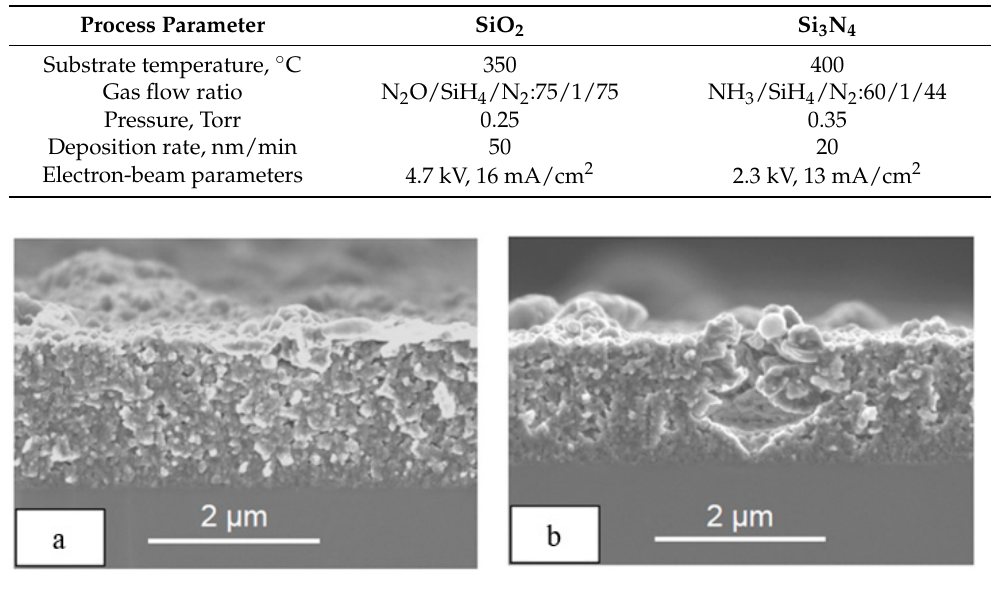
Figure 7. Al 2 O 3 coating: ( a ) cross-section of the coating on steel, ( b ) cross-section of the coating on tool steel with a defect [72]. tool steel with a defect